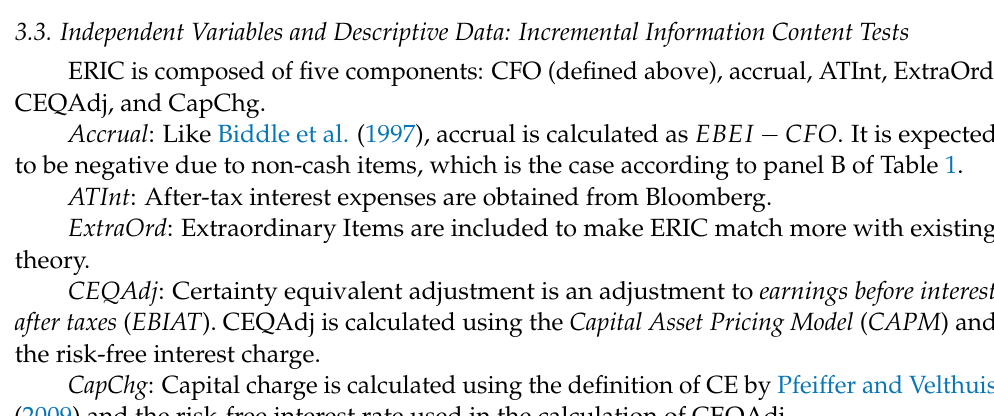
Figure 1. Median values of performance measures, 2003–2012.